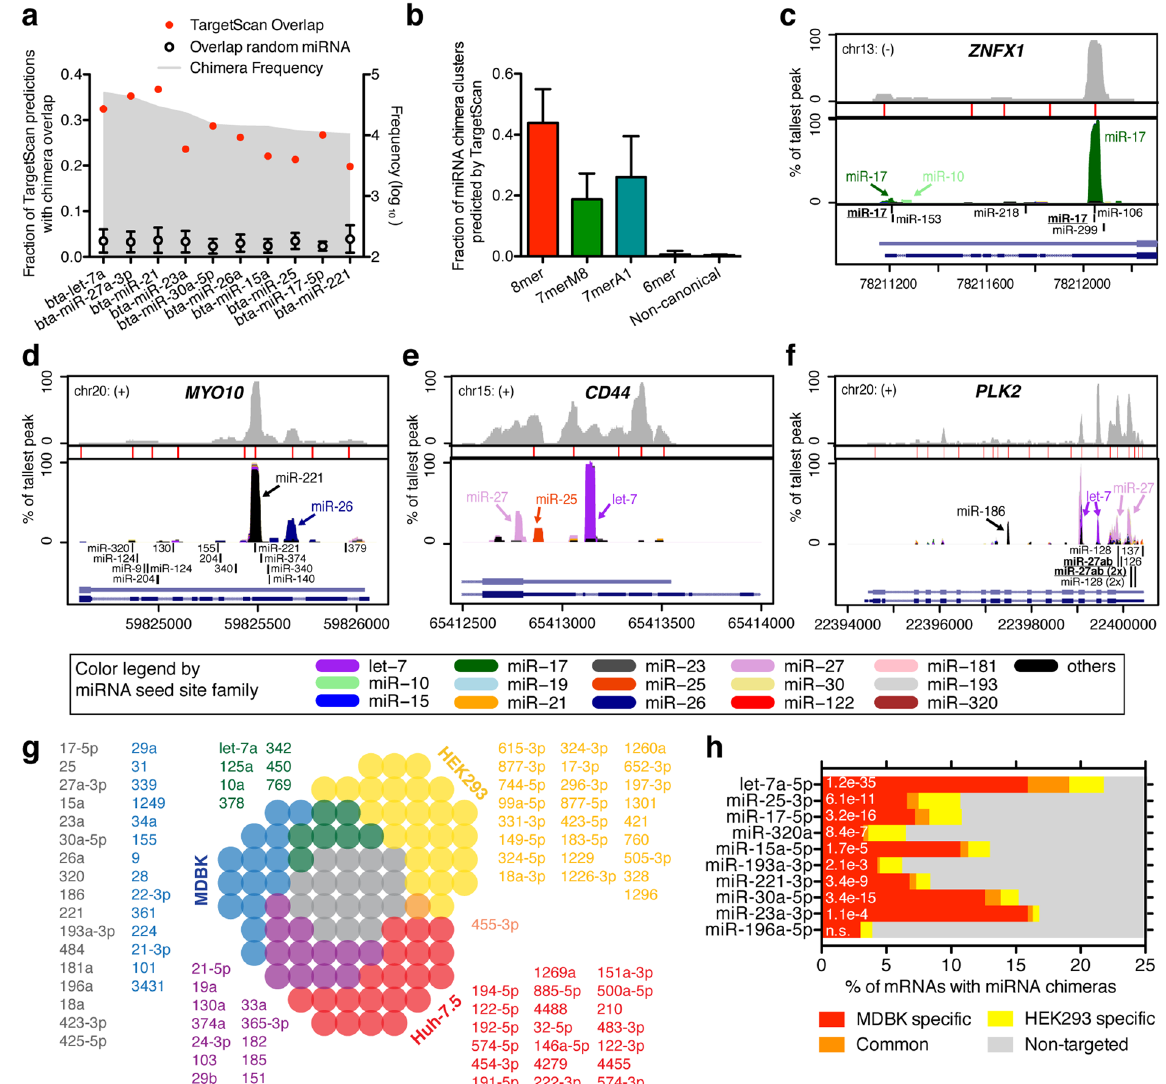
Figure 2. miRNA chimera defined target sites and overlap with TargetScan. (a) Fraction of TargetScan predictions with chimera overlap shown for the most abundant miRNAs. (b) Fraction of miRNA family chimera clusters predicted by TargetScan, shown by presence of canonical seed site. (c – e) Specific mRNA 3 ′ UTR profiles of AGO-CLIP data (top, light grey), significant peaks (red bars), miRNA chimera data (middle, colored by miRNA family, see legend at the bottom), TargetScan predictions (bottom, black bars) and mRNA structure (bottom, light blue: cow; dark blue: human/others). (f) miRNA target data as in ( b – e ) but for the entire PLK2 mRNA. (g) Overlap of top 50 miRNAs between bovine kidney (MDBK), human kidney (HEK293) and human liver (Huh-7.5) cells is shown as a to-scale Venn diagram. Color coded miRNAs from each group are listed in order of abundance. (h) Overlap in miRNA targetome between MDBK and HEK293 cells is shown as percentage of chimera targeted mRNAs for individual miRNAs. The significance of overlap was evaluated using the hypergeometric test, and p-values are given. n.s.: not